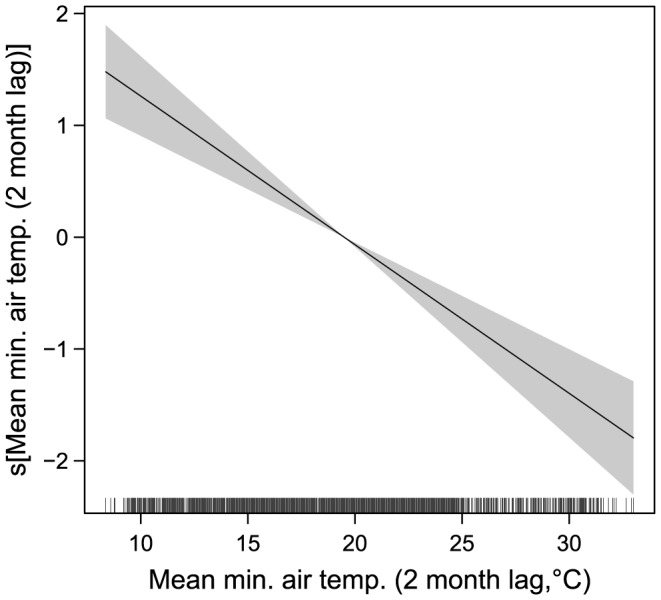
Relationship between offshore/migratory cetacean mortality and mean minimum air temperature (lagged by 2 months).The solid line is the smoother from the final GAMM model and the shaded area represents the 95% confidence intervals. The vertical black lines on the x axis denote individual values. A Poisson error and log-link function were used for this relationship, the response surface is on the scale of the linear predictor.